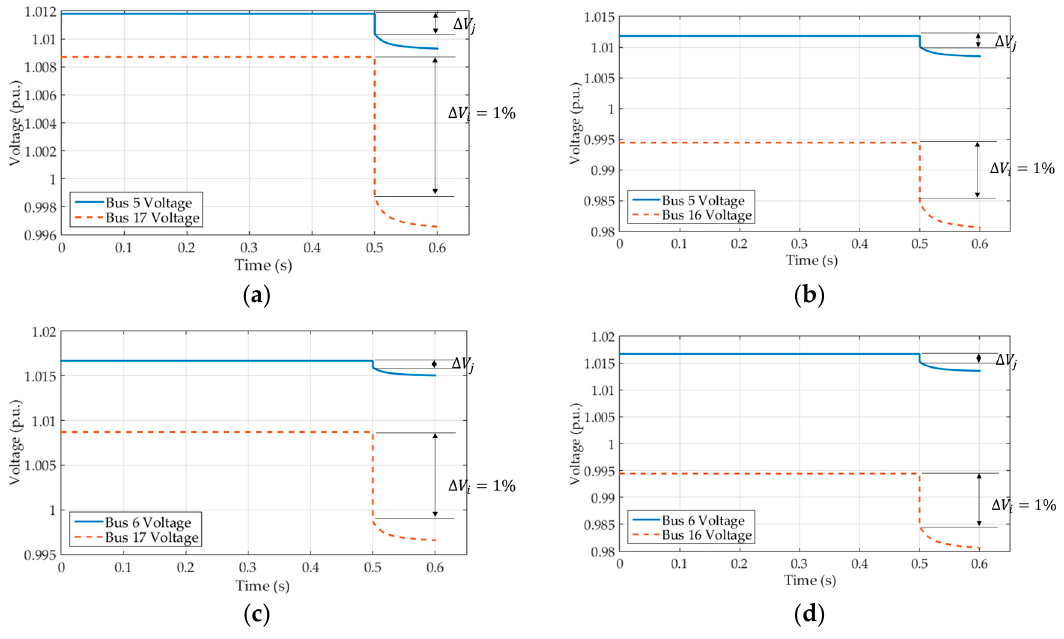
Figure 6. Test system case 2 MIIF simulation result by dynamic method: ( a ) MIIF1 simulation result; ( b ) MIIF2 simulation result; ( c ) MIIF3 simulation result; and ( d ) MIIF4 simulation result.